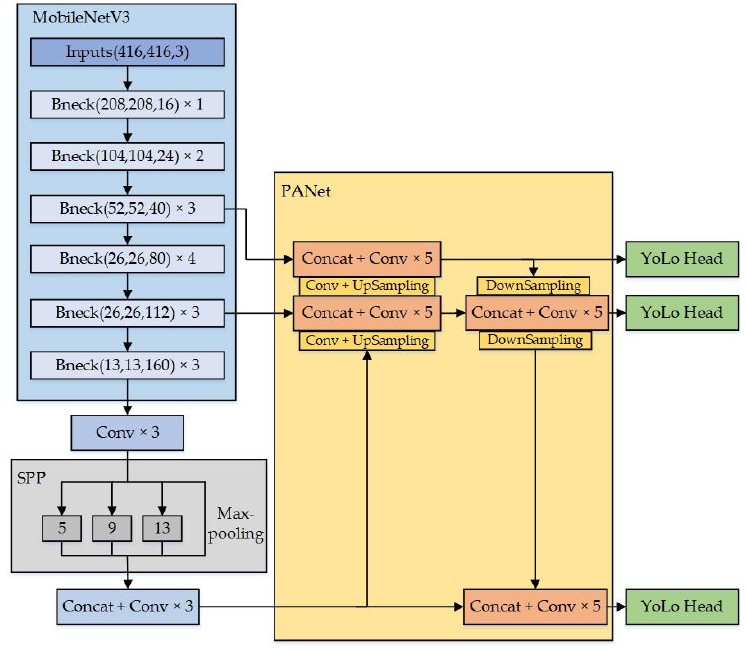
Figure 3. Improved